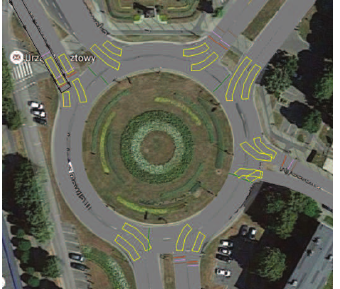
Fig. 4. Vissim model of existing two-lane roundabout